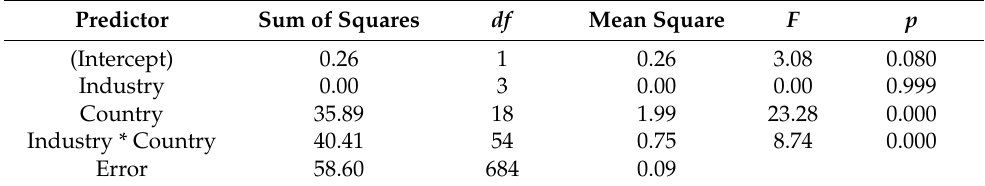
Table 6. ANOVA results using index value as the criterion. Source: own